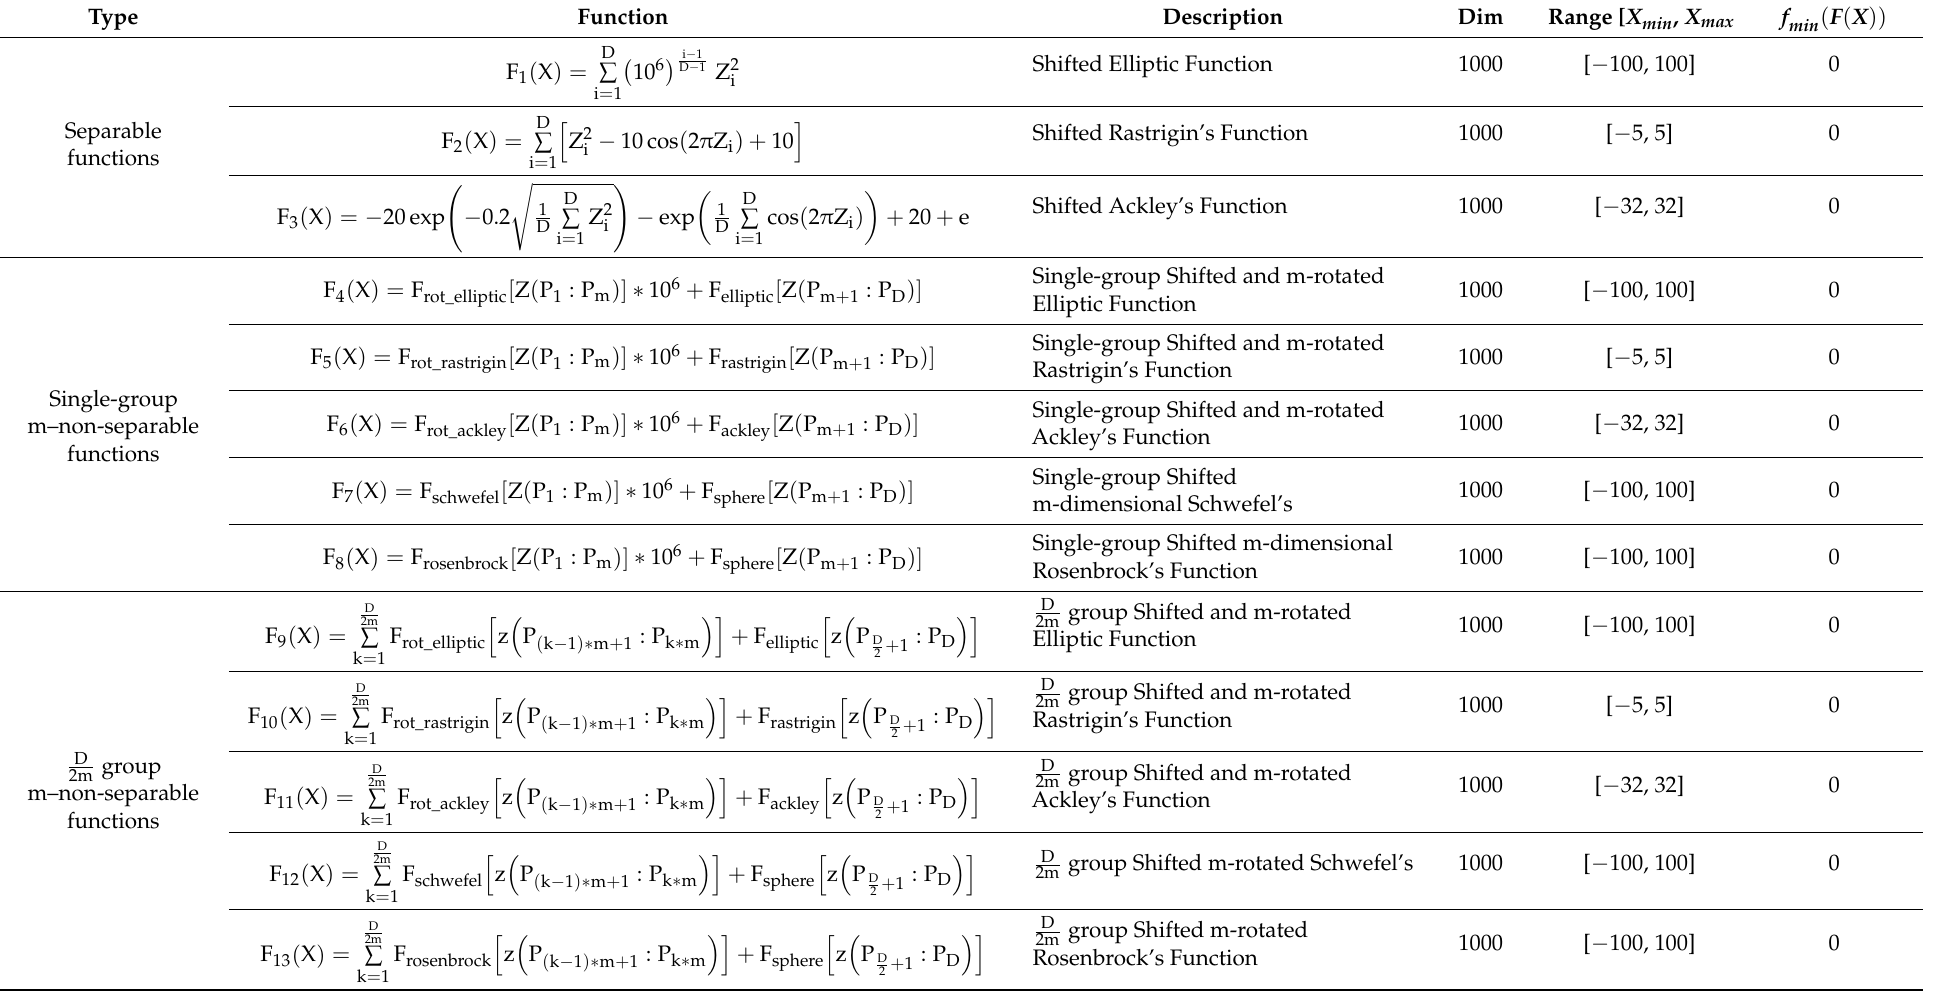
Table 1. Description of 1000-D CEC’2010 large-scale benchmark